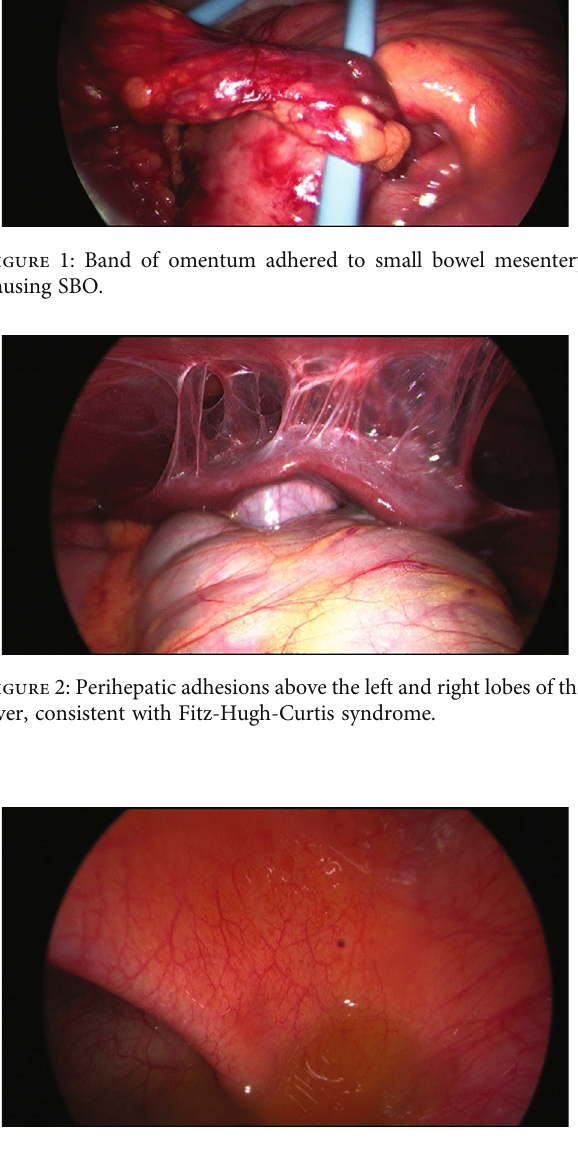
Figure 3: Dark macular lesion on the right abdominal